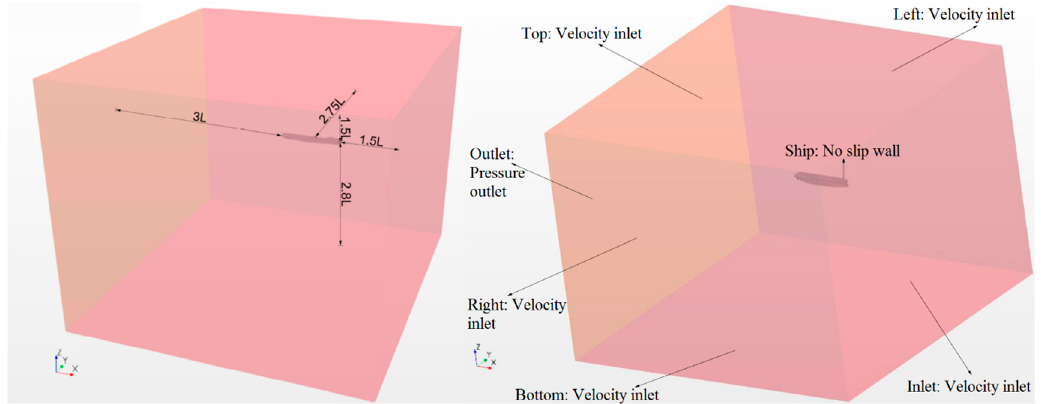
Figure 4. Computational domain ( left ) and the applied boundary conditions ( right ) within computational fluid dynamics (CFD) simulations of the self-propulsion test (SPT).